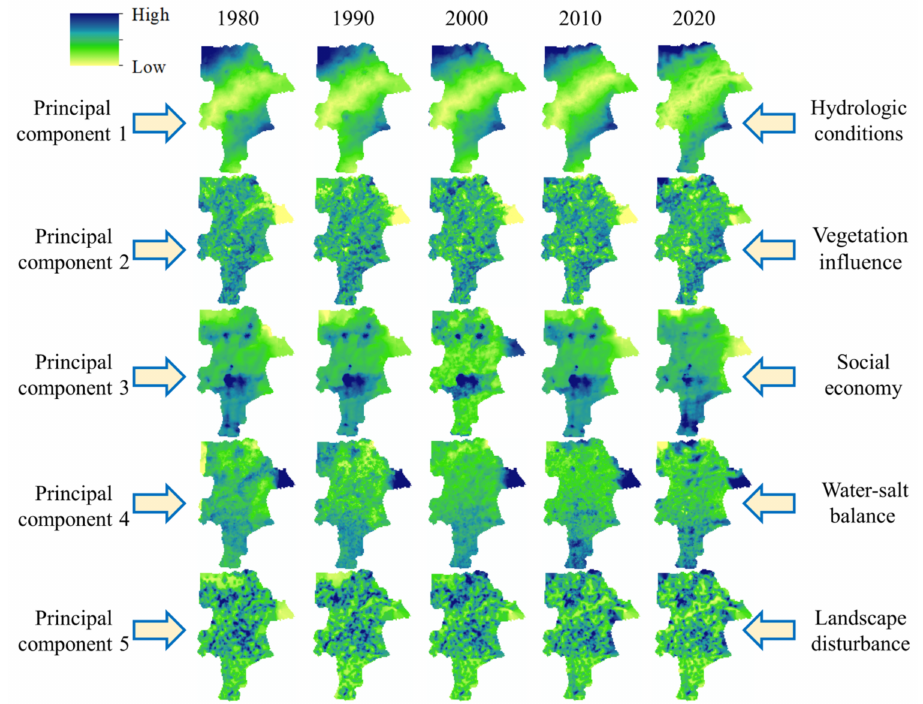
Figure 7. Principal components of social–economic drivers in the Yellow River Delta, 1980–2020.